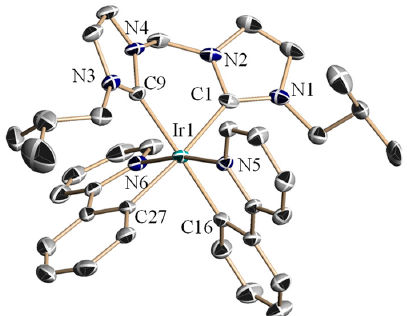
Figure 3. Molecule structure of 4b in the solid state. Hydrogen atoms, disorder of the side arms and non-coordinating anions are omitted for clarity. Selected distances [Å] and angles [°]: Ir1-C1 2.107(3), Ir1-C9 2.130(3), Ir1-C16 2.049(3), Ir1-C27 2.052(3), Ir1-N5 2.051(2), Ir1-N6 2.058(2),